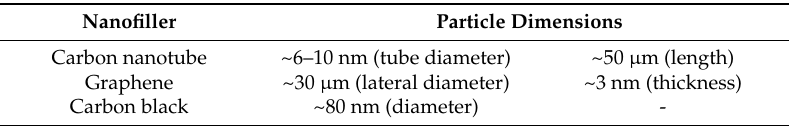
Table A1. Detailed parameters of